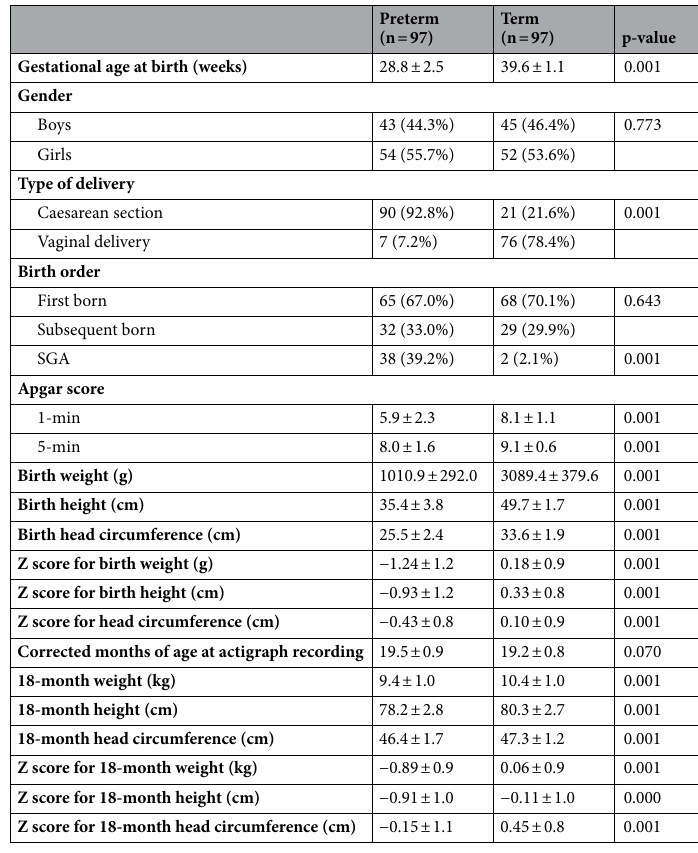
Table 1. Demographic characteristics of participants (number (%) or mean ± SD). SGA: Small for gestational age.